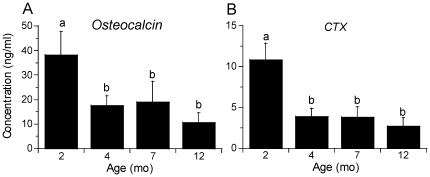
Systemic bone turnover decreases with age.Serum was collected from baseline control (non-loaded) mice of four different ages, and indices of bone turnover were measured by ELISA. (a) Osteocalcin, a marker of bone formation, and (b) carboxyl-terminal collagen cross-links (CTX), a marker of bone resorption, declined significantly with age. (n = 8; mean ± SD; a,b: groups with no common letters are significantly different, p<0.05).